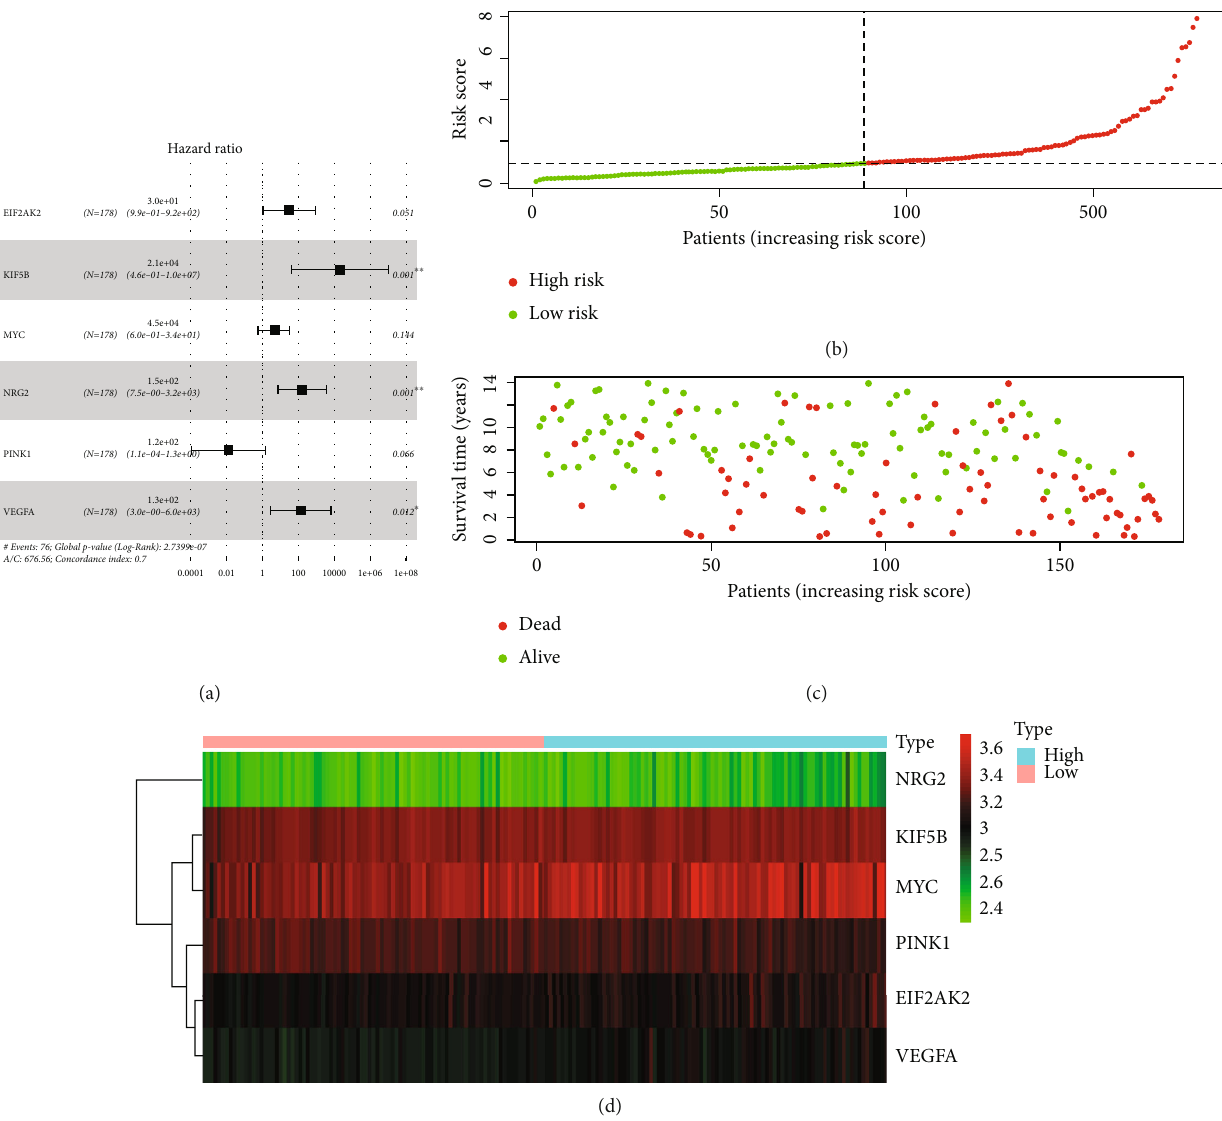
Figure 2: Screening and veri fi cation of OS-related ARGs in patients with MM. (a) The risk score was computed using the prognostic model as a basis. (b) Distribution of risk scores in patients. (c) Survival time of high- and low-risk patients with the increasing risk scores. (d) Expression of six OS-related ARGs in patients with MM in the high- and low-risk